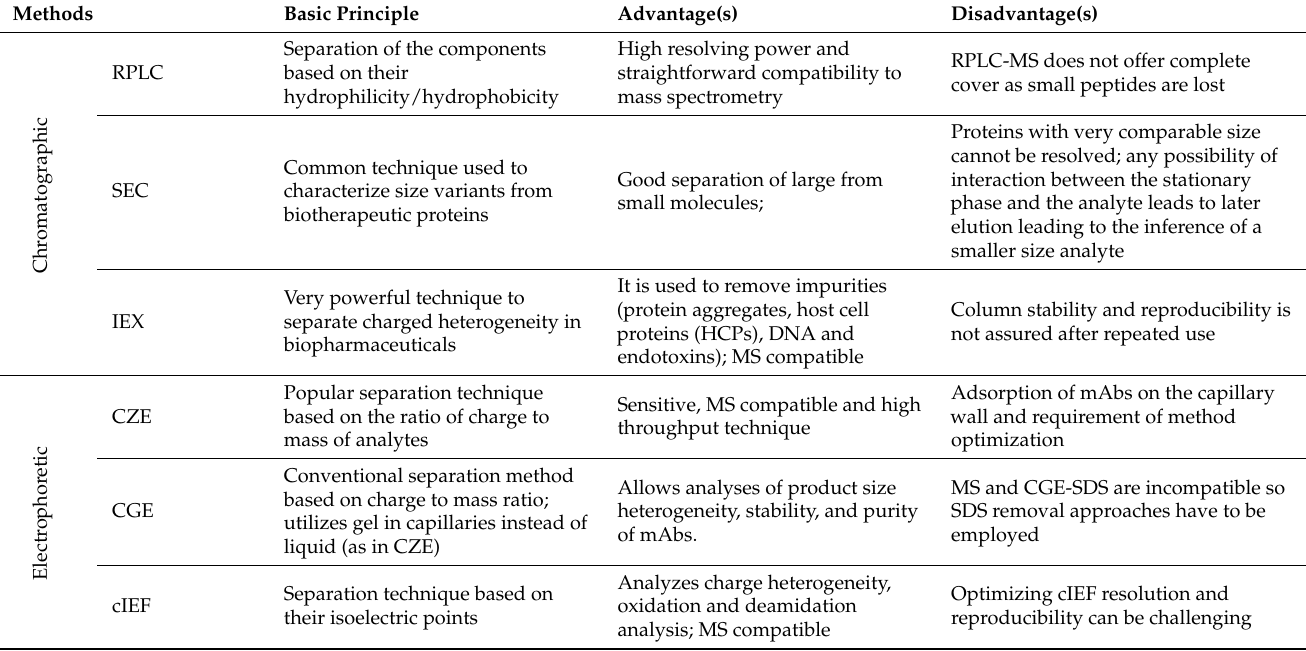
Table 3. Comparison of analytical methods used for antibody characterization with their respective advantages and